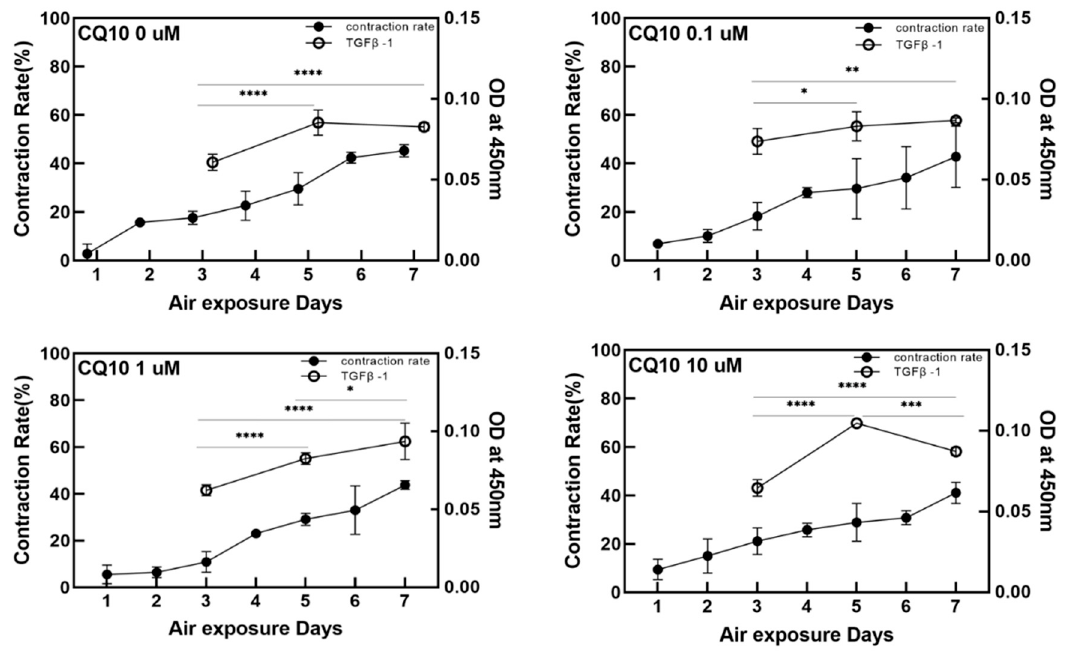
Figure 4. Variation of the contraction rate of the samples (left Y -axis) and the relative optical intensity of the transforming growth factor (TGF) β -1 from enzyme-linked immunosorbent assay in the culture media as a function of the air exposure period (right Y -axis) with the four different concentrations of coenzyme Q10. ( p -value: * < 0.05, ** < 0.01, *** < 0.001, and **** < 0.0001).